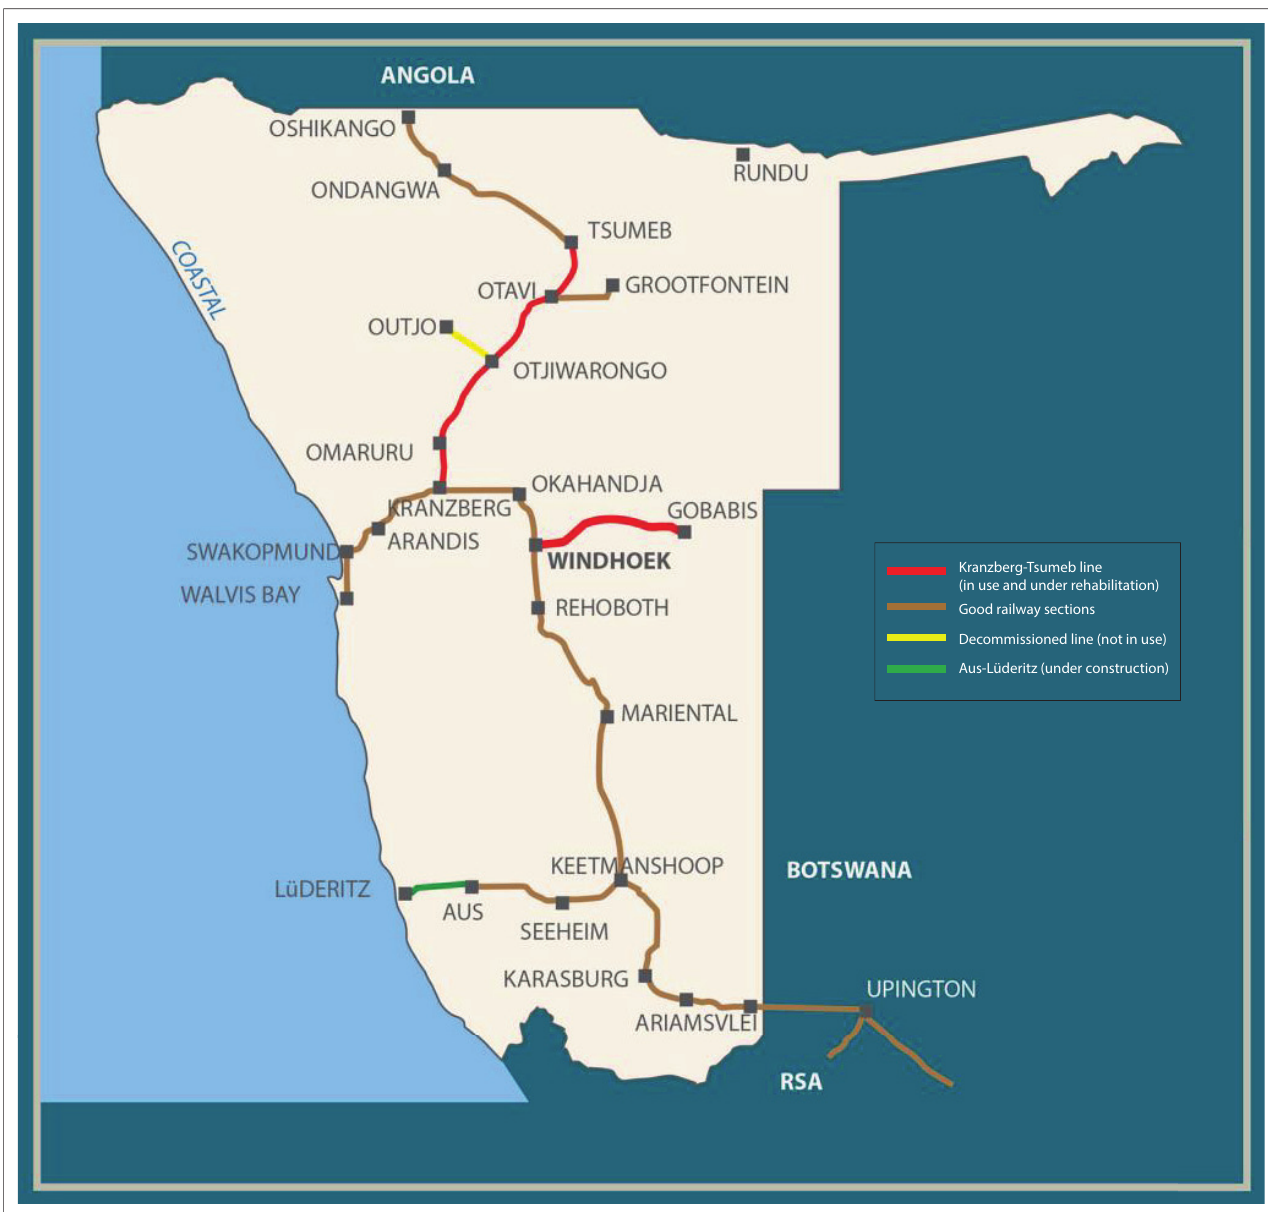
FIGURE 1: Railway line network across Namibia.